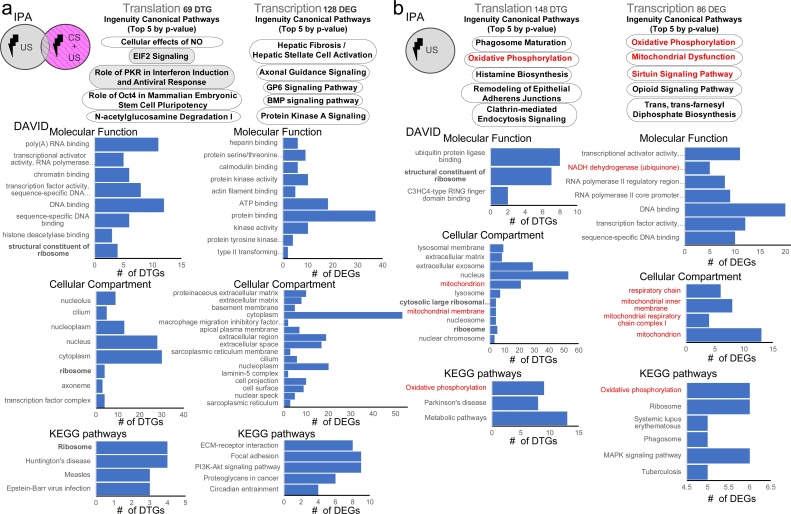
Ingenuity Pathway Analysis and DAVID Gene Ontology of DEGs and DTGs from CFC minus immediate shock and immediate shock groups. TOP: IPA Canonical pathway analysis showing the top 5 categories for DTGs (Translation) and DEGs (Transcription) for the CFC minus immediate shock group a. and the shock only group b. BOTTOM: For both a. and b. DAVID analysis showing Molecular Function, Cellular Compartment and KEGG Pathways GO categories in ascending p-value order (Bonferroni’s post-hoc). Categories discussed in the text are highlighted. See also Supplementary Table 3.